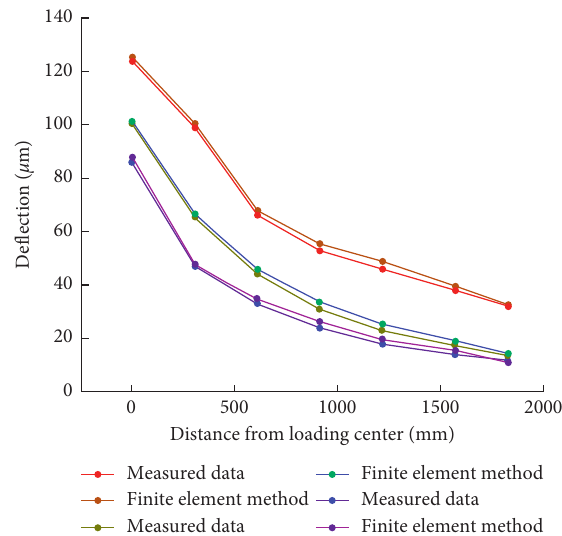
Figure 5: Comparison of deflection results at different measuring